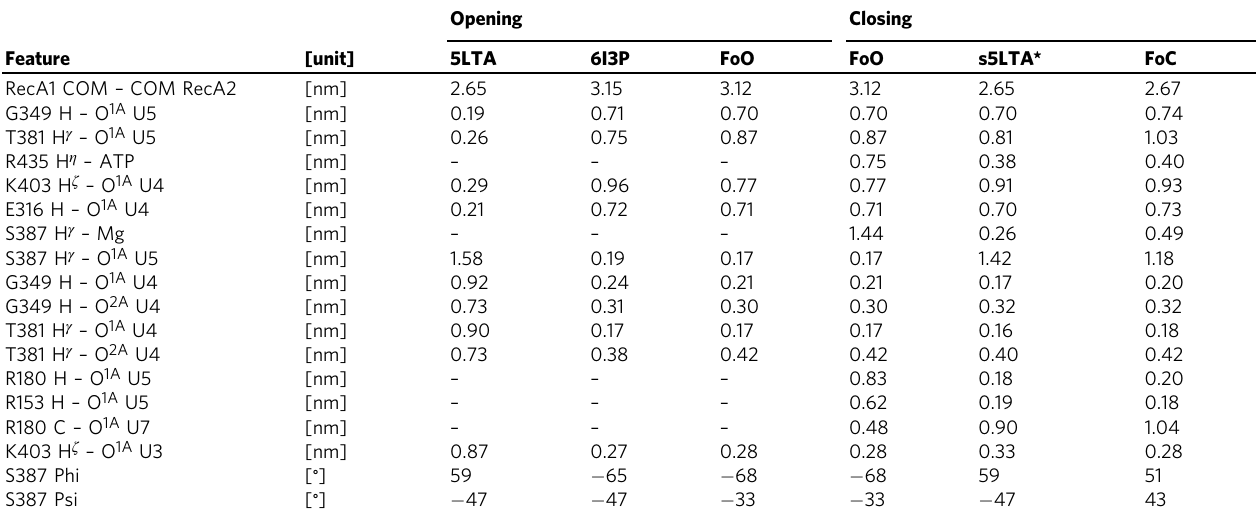
Table 1 Structural features used to monitor the progress of opening and closing transitions. Opening